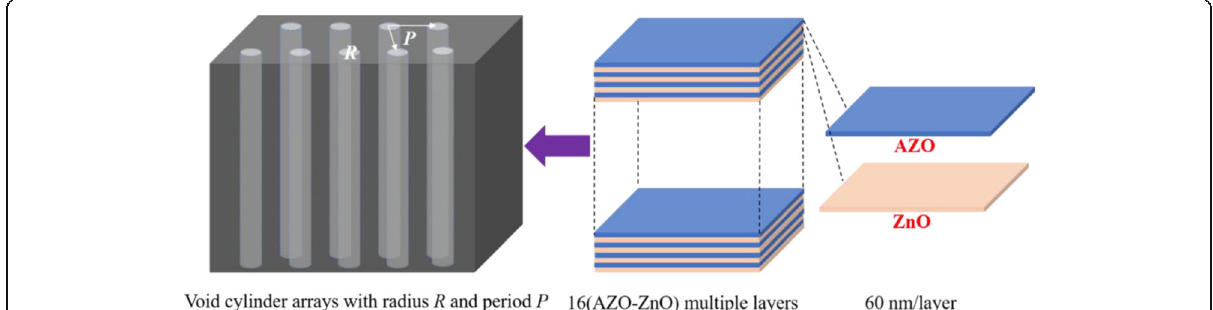
Fig. 7 The structure of void cylinder arrays on AZO/ZnO alternative layers. The radius of the void cylinder arrays is R μ m, and the period is P μ m. The thickness of 32 layers of AZO/ZnO alternative films is approximately 1.92 μ m, each layer being 60 nm thick